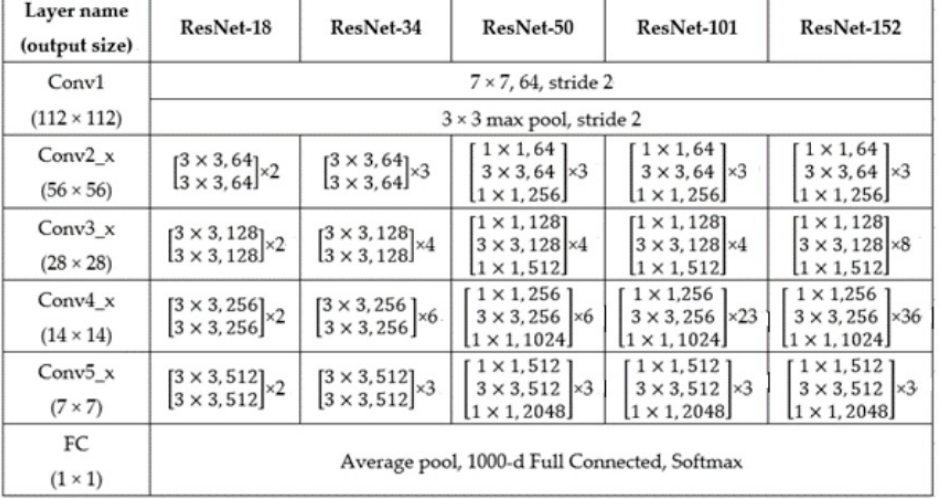
Figure 3. Details of each layer in the ResNet architecture [22].